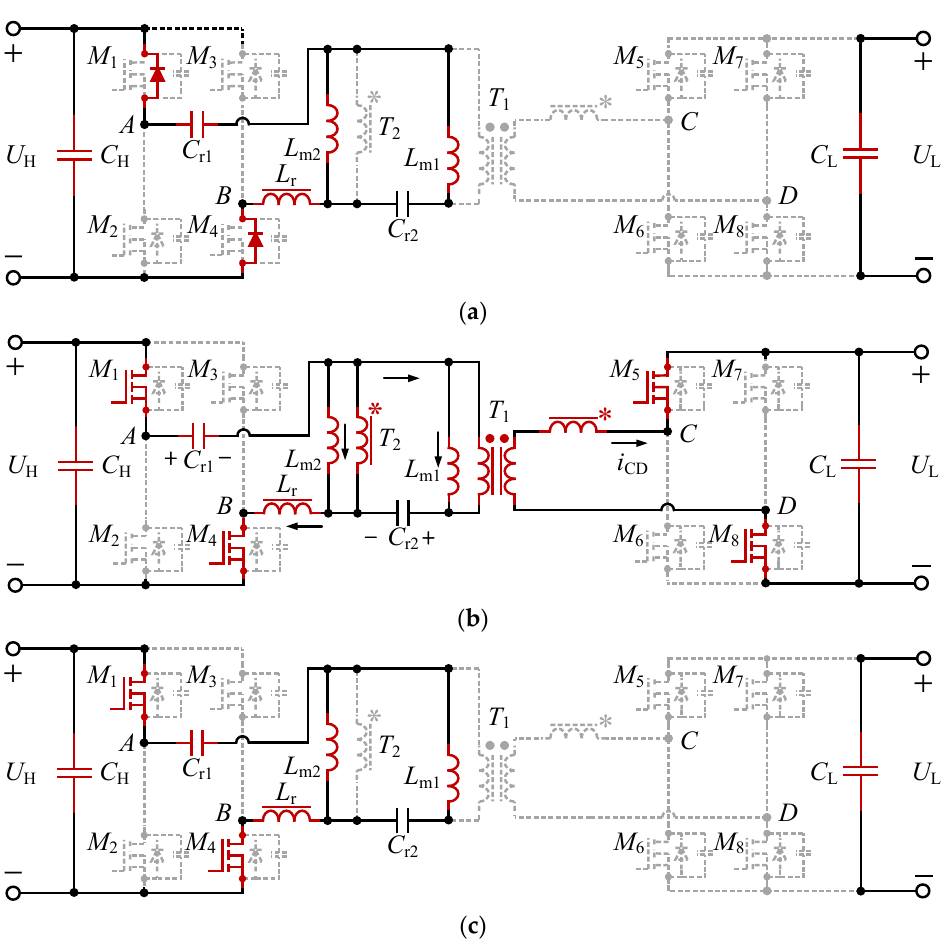
Figure 3. Equivalent circuits in step-down mode: ( a ) Interval A; ( b ) Interval B; ( c ) Interval C (The symbols of “*” are dotted terminals of T 2 ).